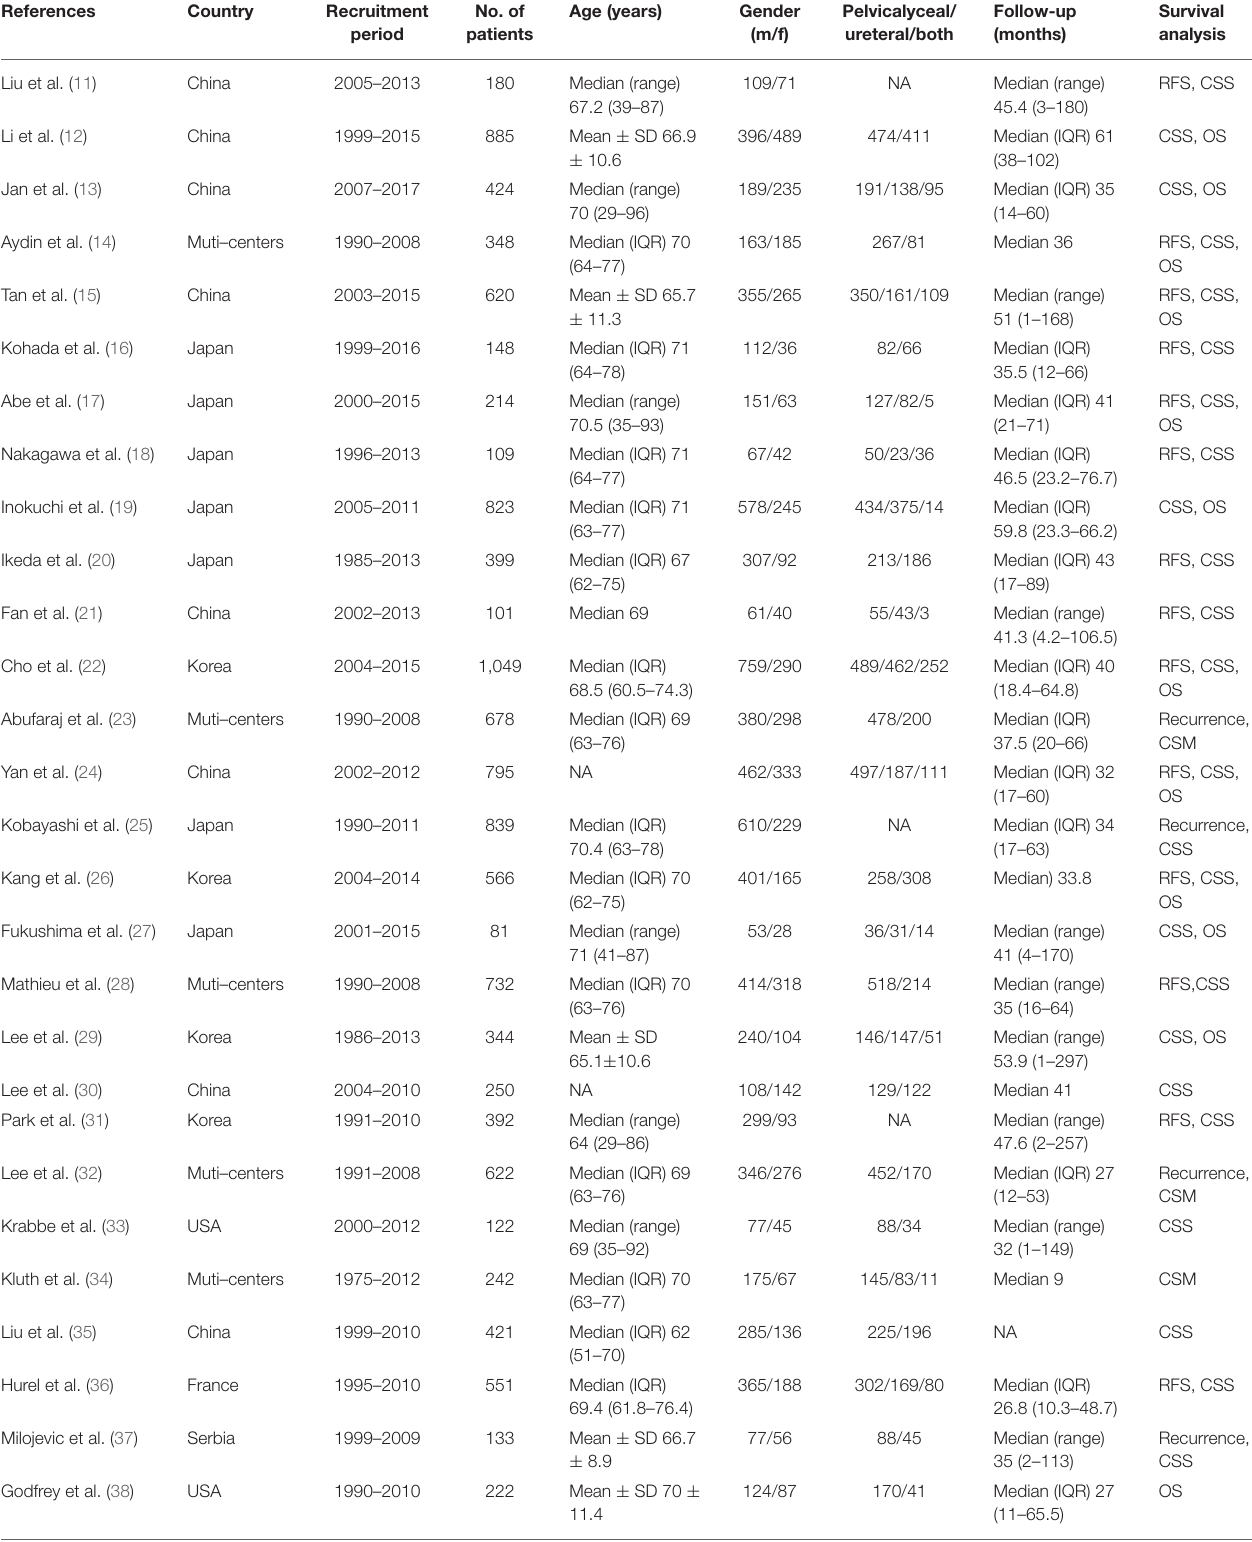
TABLE 1 | Clinical characteristics of the included studies in this